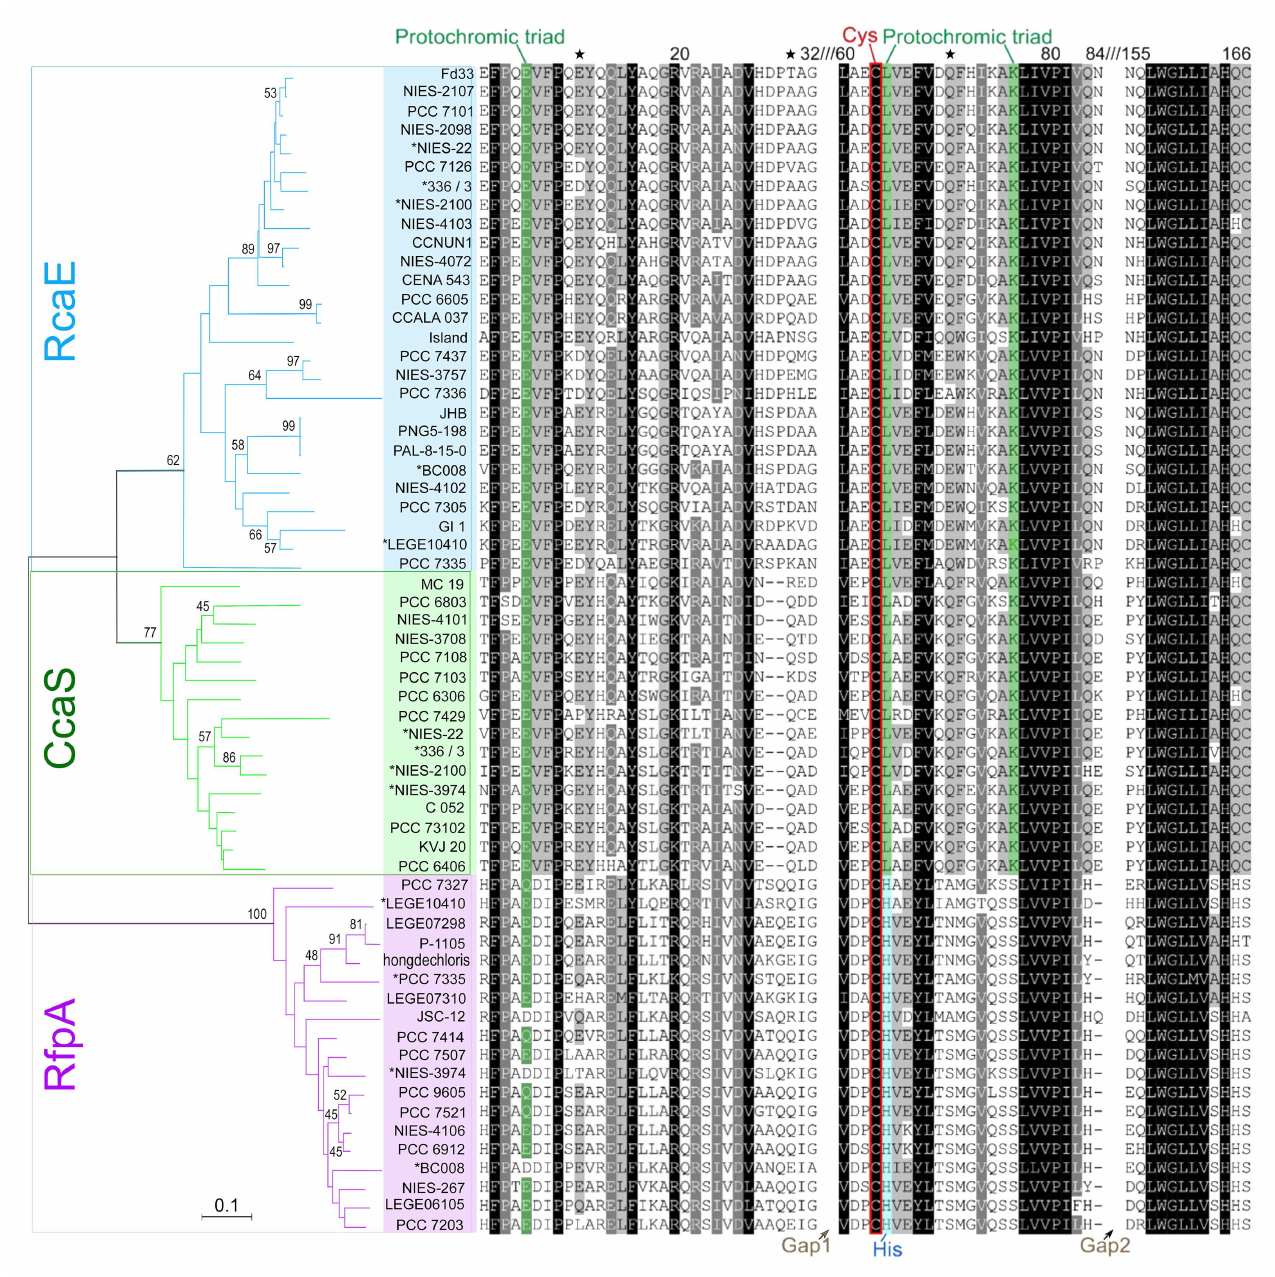
Figure 1. Phylogenetic analysis and GAF domain alignments of photoreceptors. The groups of RcaE (Blue), CcaS (green), and RfpA (purple) are supported by the alignment fragments of GAF domains. The conserved Cys sites are highlighted in a red framed box. The protochromic triad sites are highlighted in green and conserved His sites of RfpA are highlighted in blue. The asterisk represents that the strain uses two different photoreceptors. The branch supports are calculated by 5000 replicates. The five-pointed stars represent the positions of Aa alignment at 10, 30, and 70, respectively. The strain culture numbers are used in the figure and the photoreceptor sequence accessions are listed in Table